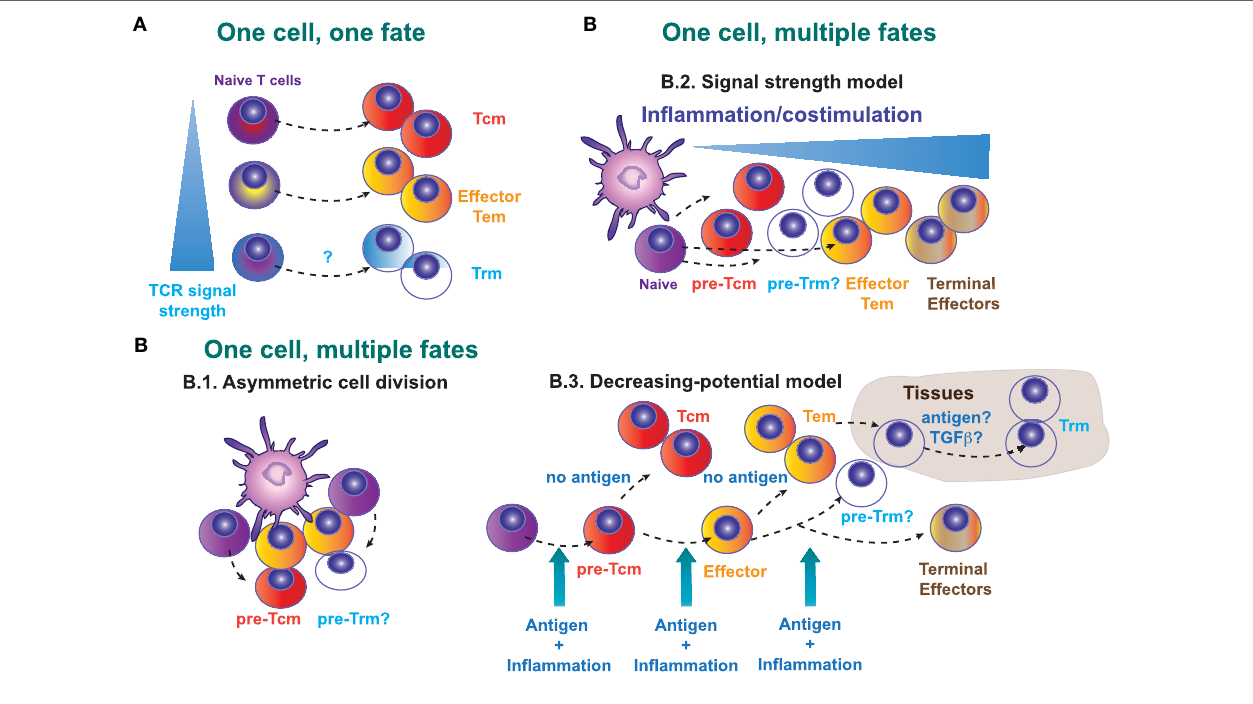
FiGURe 1 | Possible models that explain the generation of a committed Trm precursor in secondary lymphoid organs. (A) One cell, one fate model. Distinct naive T cells will exhibit a different lineage decision determined by the quality (intensity of signal) of their TCR. (B) One cell, multiple fates model. B.1., Asymmetric cell division in T lymphocytes may determine fate diversification. B.2., Signal strength model. The strength of the signals 1, 2, and 3 determines the fate of the activated CD8 + T cells, with low strength signals generating central memory T (Tcm) precursors and high strength supporting the generation of terminal differentiated effectors. B.3., Decreasing potential model. This model proposes that a short duration of antigenic stimulation favors development of activated cells that will give rise to greater numbers of Tcm cells, while longer duration of stimulation promotes terminal effector cell differentiation and